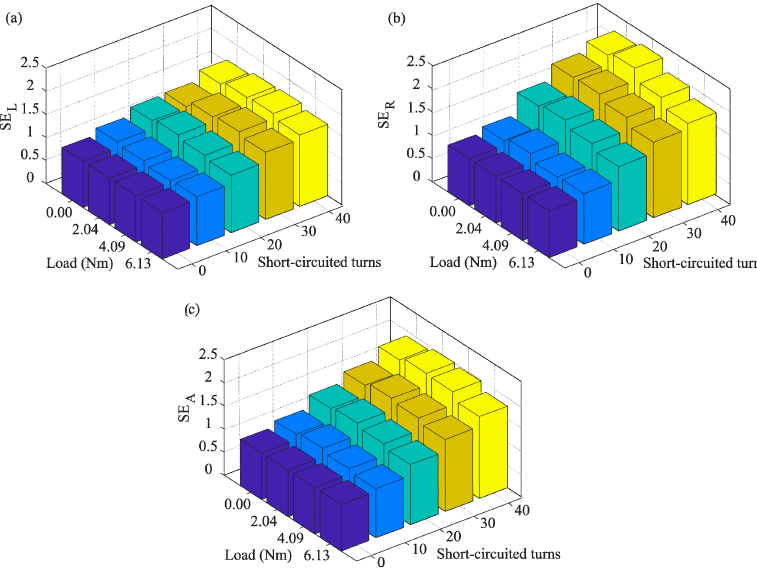
Figure 7. SE values for ( a ) f L , ( b ) f R , and ( c ) SE A at both different loads and different fault severities.